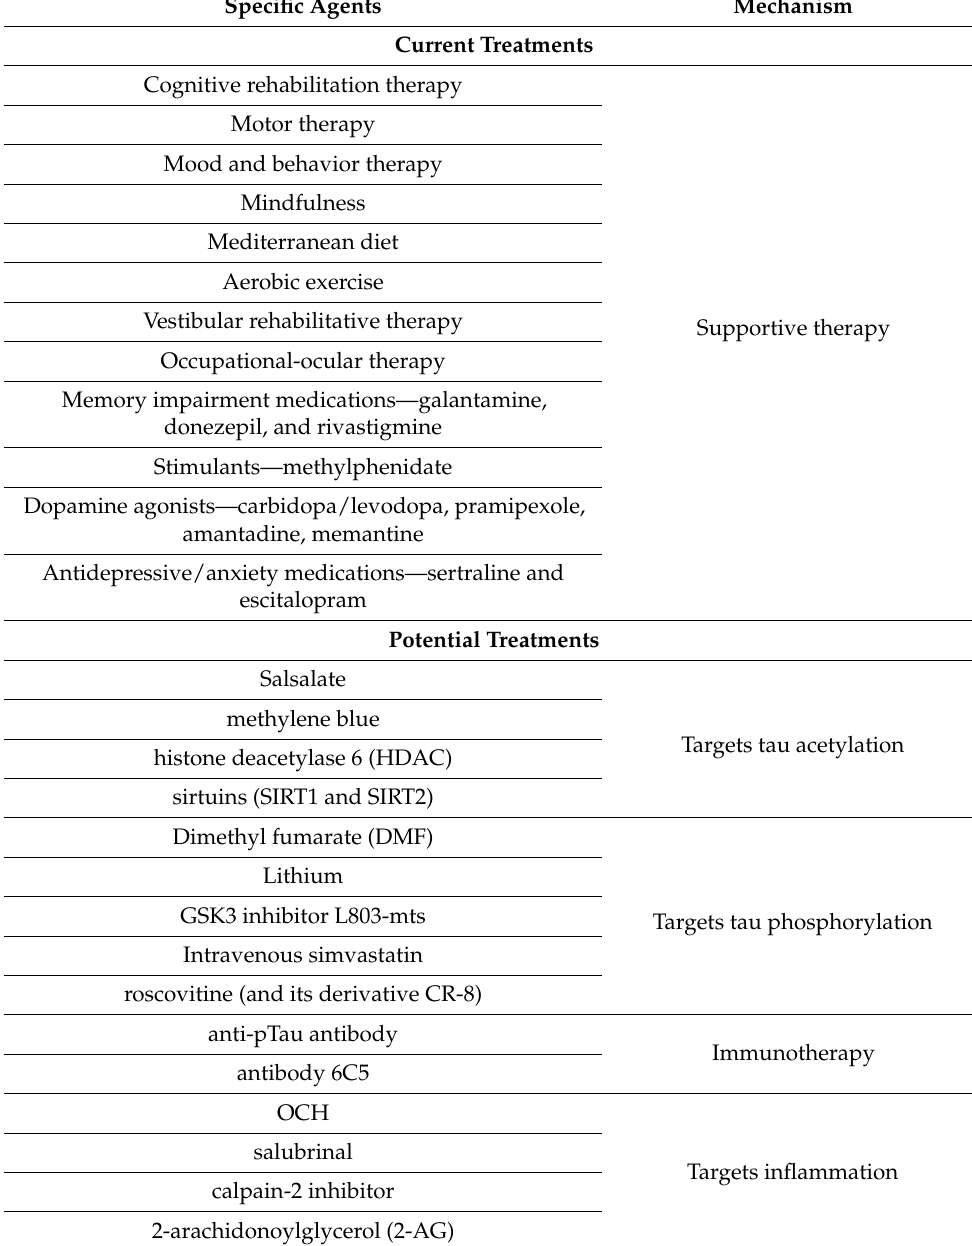
Table 2. Innovation in Treatment of